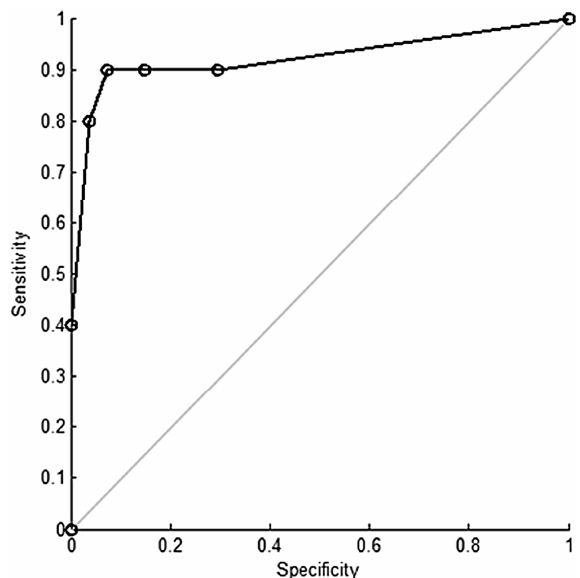
Figure 12. Receiver operating characteristic (ROC) curve of the model predicting the presence of bacterial airway colonization in COPD patients. Used with permission from [88].